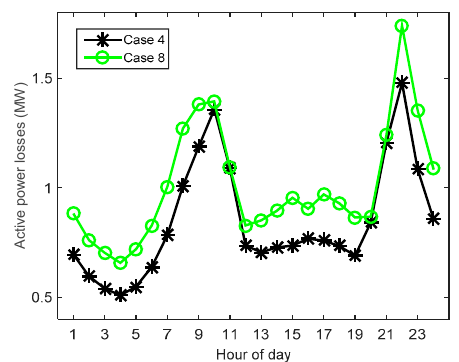
Figure 15. Active power losses of the network in Cases 4 and 8.